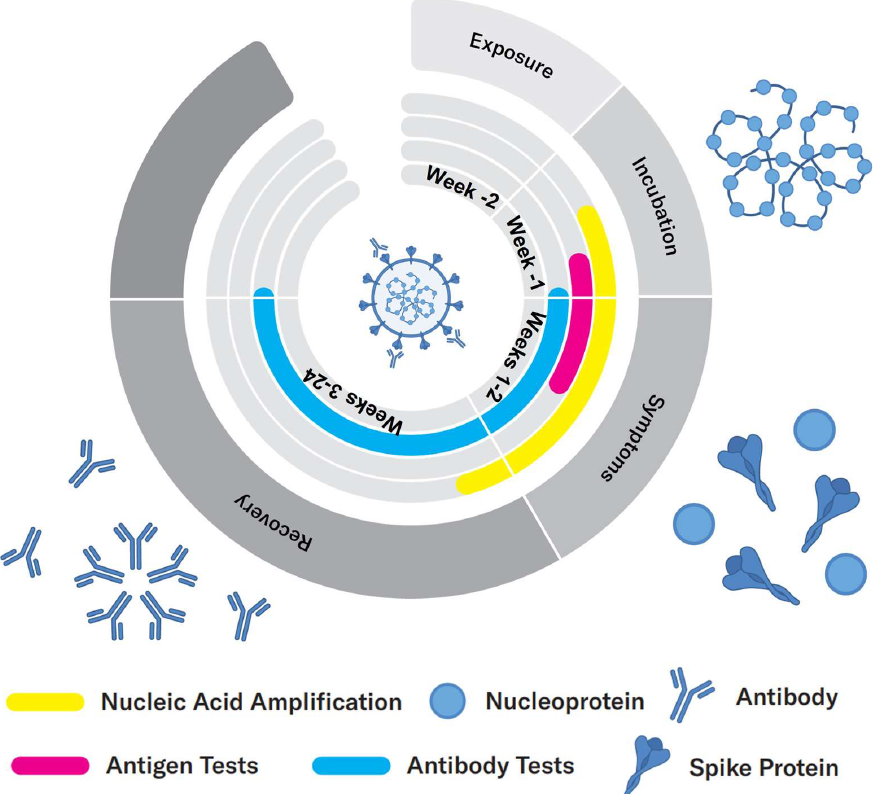
Figure 1. Schematic of the evolution of SARS-CoV-2 infection and timeline for detection via different types of tests. Taking the onset of symptoms as a baseline, it takes approximately 1–14 days from exposure with the virus to exhibit symptoms (exposure and incubation period in week -1 and week -2). The symptoms usually last for 1–2 weeks (weeks 1–2) for mild cases before recovery. For a severe